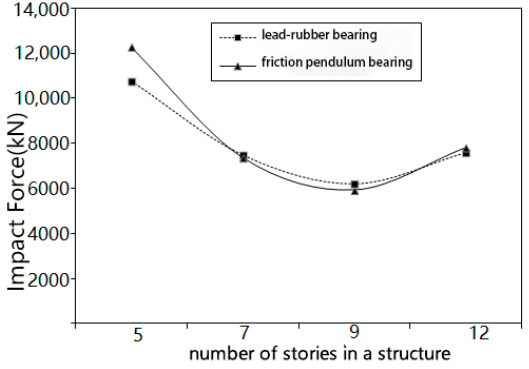
Figure 13. Curves of impact force changes with story.